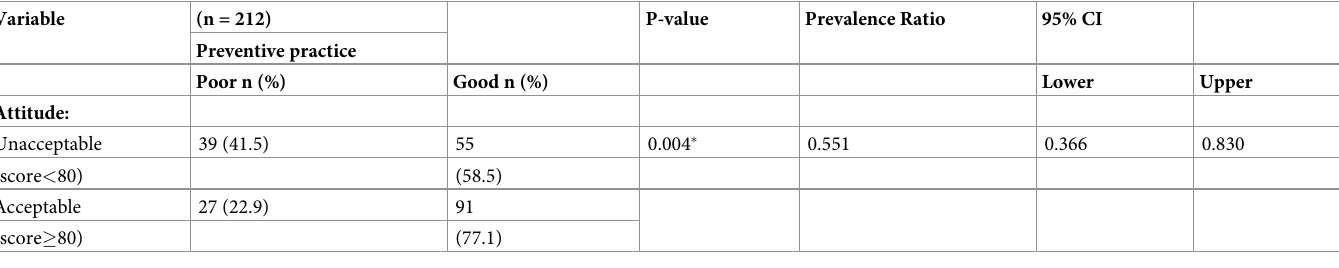
Table 13. Association between the respondents’ attitude with the preventive practice of food